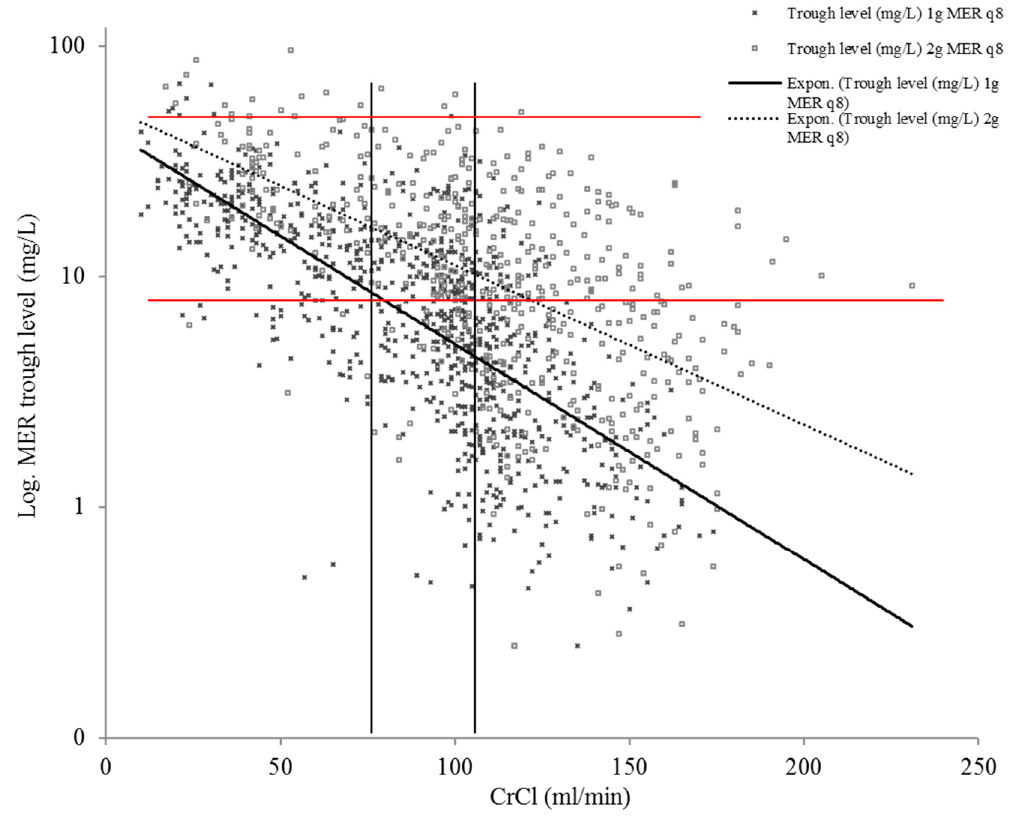
Figure 1. The distribution of meropenem trough level concentrations with the administration of 1 g (q8) and 2 g (q8) in relation to the individual creatinine clearance (CrCl) in patients without renal replacement therapy. The vertical black lines demarcate groups 1–3, and the red horizontal lines denote the breakpoint for target attainment and the toxic breakpoint. Note: log: logarithmic, MER: meropenem, CrCl: creatinine clearance .